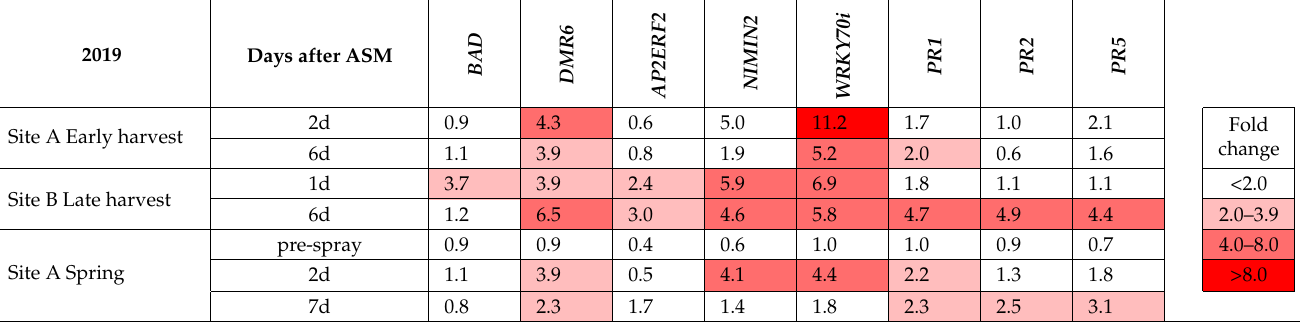
Table 1. Heat map showing the expression of defence-related genes in Actinidia chinensis var. deliciosa “Hayward” in 2019. Vines were sprayed with acibenzolar-S-methyl (ASM) after harvest at site A on 8 May and at site B on 24 May. Pre-flowering ASM + Cu at site A was applied on 30 October. Data were log2 transformed for analysis. The numerical values indicate the fold-change relative to the copper control. Fold-changes of two or higher (or 0.5 or lower) were all statistically significant ( p <